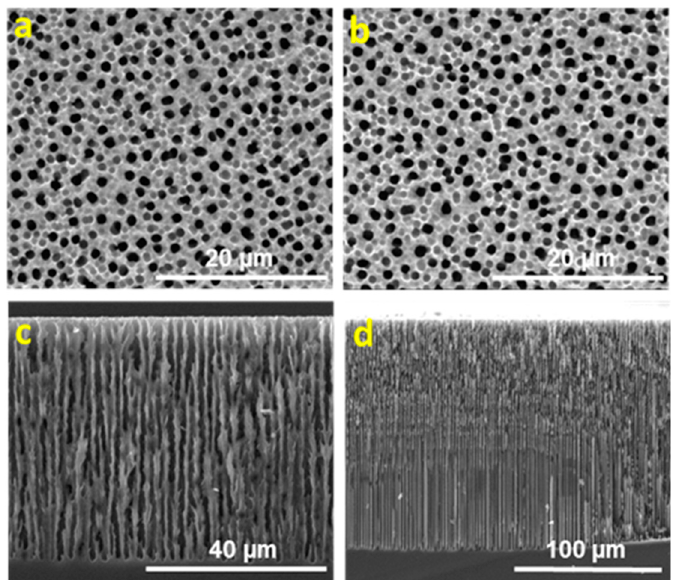
Figure 2. ESEM image of top and cross-sectional view of MacroPSi substrates with 10 Ω cm resistivity: ( a , c ) MacroPSi-3: HF:DMF = 1:3, current density = 10 mA/cm 2 , etching time = 90 min and porosity = 30.2 ± 1.4%; ( b , d ) MacroPSi-4: HF:DMF = 1:3, current density = 20 mA/cm 2 , etching time = 90 min and porosity = 27.5 ± 0.4%.